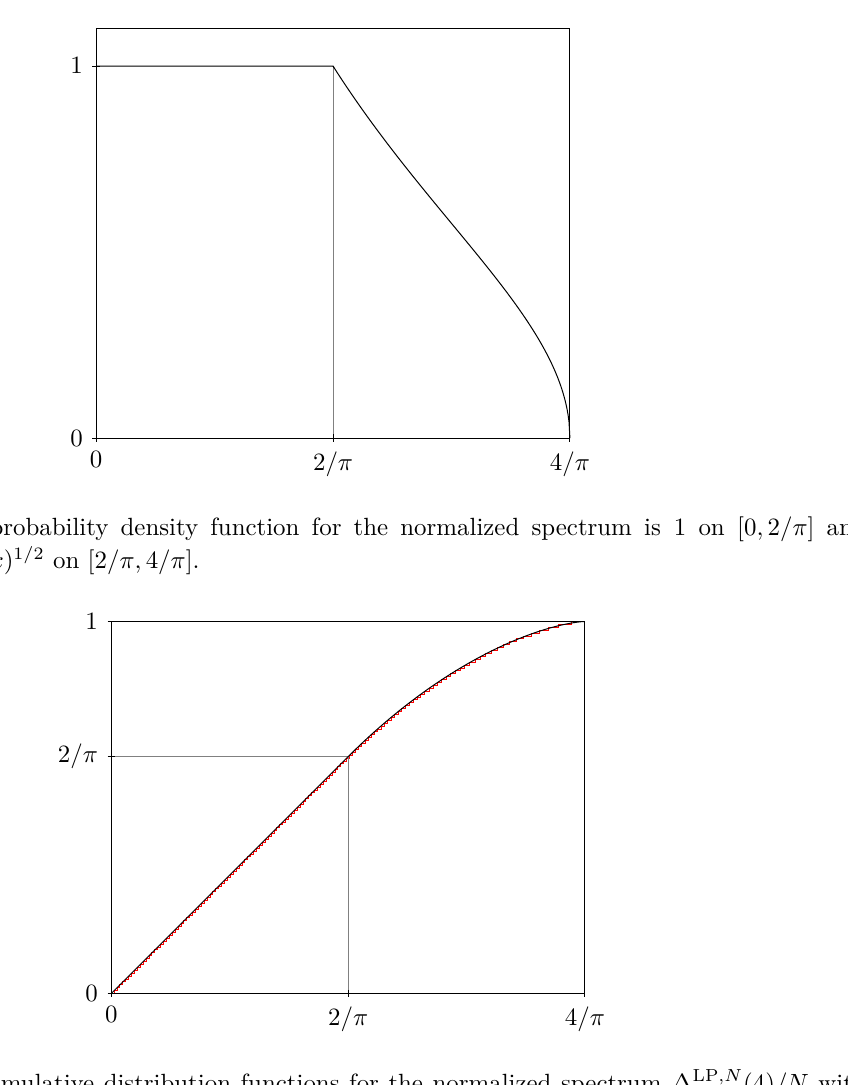
Figure 8 . The cumulative distribution functions for the normalized spectrum ∆ LP ,N 1 ≤ n ≤ N when N = 128 (red) and in the limit as N → ∞